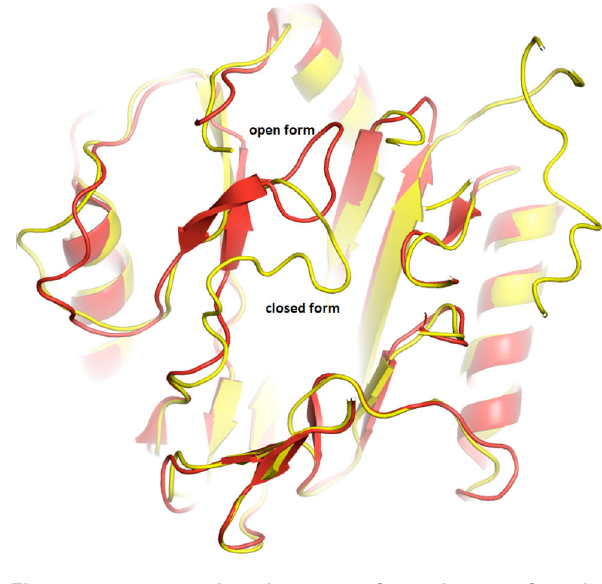
Figure 5. Inactive conformation of the Sp MetAP1a. Cartoon representation of the structural alignment of Sp MetAP1a (yellow) and Ec MetAP1a (red). Note that the β-hairpin loop collapses in to the active site there